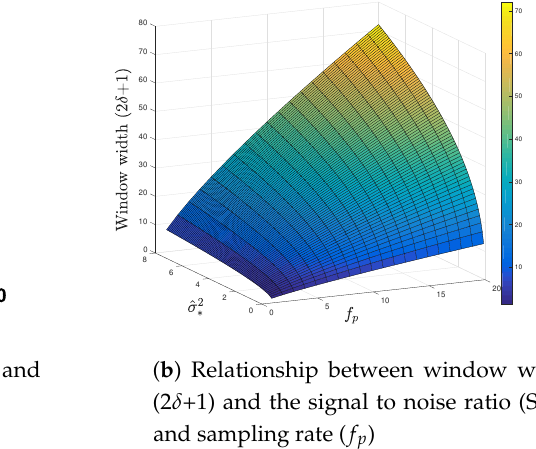
Figure 5. The relationship between ψ n , window width (2 δ +1), f p , and SNR. ( a ) The relationship between SNR, optimal ψ n in AGGF. ( b ) Relationship between window width (2 δ +1), noise level (ˆ σ 2 ∗ ), and sampling rate ( f p ) in